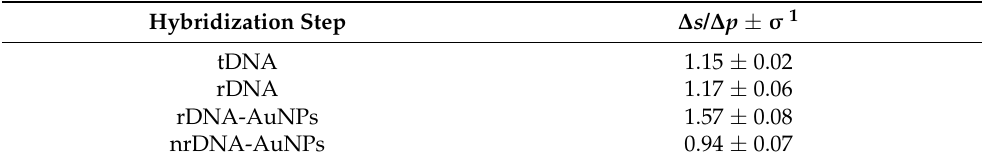
Table 1. R CT relative variation for the sandwich experiment in hybridization assay (tDNA, rDNA, rDNA-AuNPs), non-complementary DNA assay